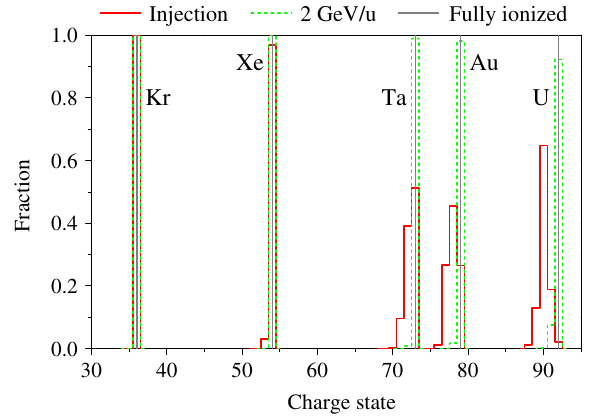
FIG. 12. Equilibrium charge state distribution of the 238 U q þ , 197 Au q þ , 181 Ta q þ , 132 Xe q þ , and 84 Kr q þ partially stripped ions interacting with 500 μ m thick titanium foil at injection energy and at 2 GeV = u with the marked fully ionized state of the